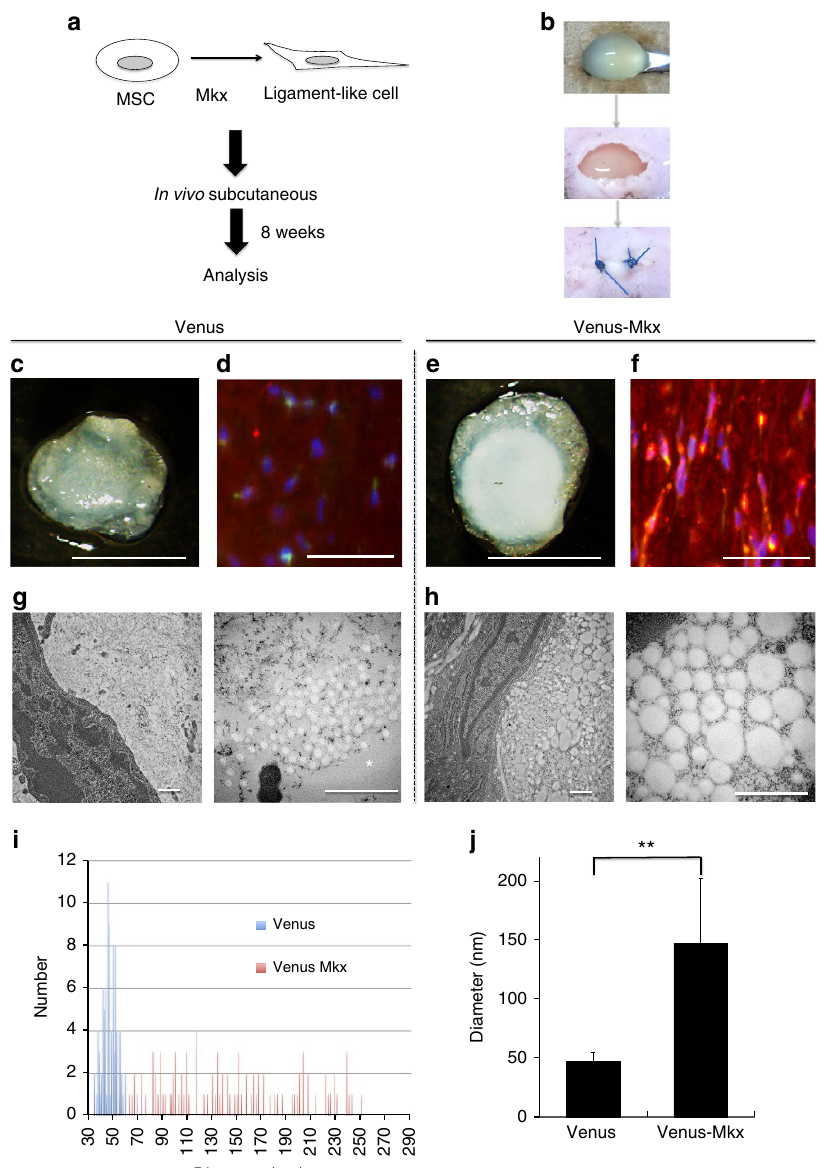
Figure 7 | Mkx -induced mesenchymal stem cells form tissue consisting of type I collagen. ( a , b ) Strategy for testing the type I collagen synthesis ability of C3H10T1/2 cells induced by Venus (C3H10T1/2-V or Venus) and Venus-Mkx (C3H10T1/2-VM or Venus-Mkx) after subcutaneous transplantation. ( c , e ) Gross appearance of products 8 weeks after subcutaneous transplantation ( c : C3H10T1/2-V; e : C3H10T1/2-VM). Scale bars, 1mm. ( d , f ) IHC of these products ( d : C3H10T1/2-V; f ; C3H10T1/2-VM). Blue, Hoechst; green, anti-GFP; red, anti-Col1a1. Scale bars, 50 m m. ( g , h ) Images of transmission electron microscopy ( g : C3H10T1/2-V; h : C3H10T1/2-VM). * The area of the collagen gel. Scale bars, 500nm. ( i ) Histogram of the diameter of collagen fibrils from C3H10T1/2-V and C3H10T1/2-VM cells. Blue bar, C3H10T1/2-V; red bar, C3H10T1/2-VM. ( j ) The calculated mean of the diameter of 100 collagen fibrils from C3H10T1/2-V and C3H10T1/2-VM cells. The mean diameter of 100 collagen fibrils was calculated: for C3H10T1/2-V cells, mean diameter ¼ 46.99nm (s.d. ¼ 7.409nm); for C3H10T1/2-VM cells, mean diameter ¼ 147.32nm (s.d. ¼ 54.54nm). Error bars represent the s.d. ** P o 0.01. Statistical differences were assessed with Student’s t -test. GFP, green fluorescent